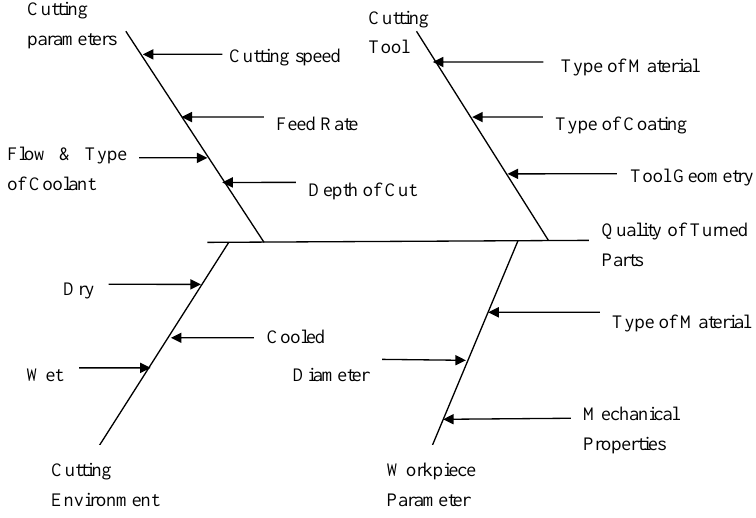
Figure 1. Fish bone diagram of parameters affecting quality of turned part [16].